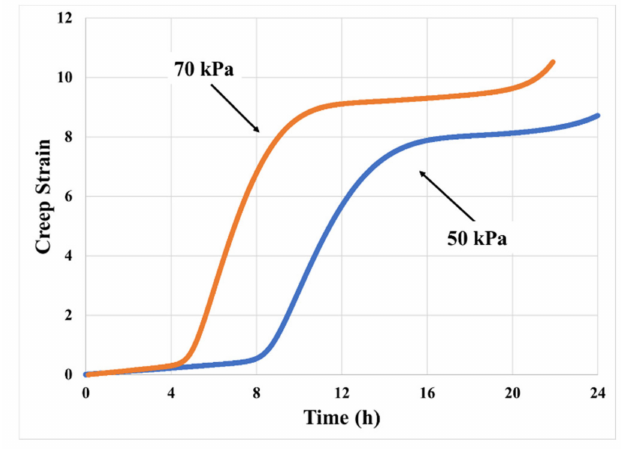
Figure 15. Effects of creep stress level on model predictions at 70 ◦ C.